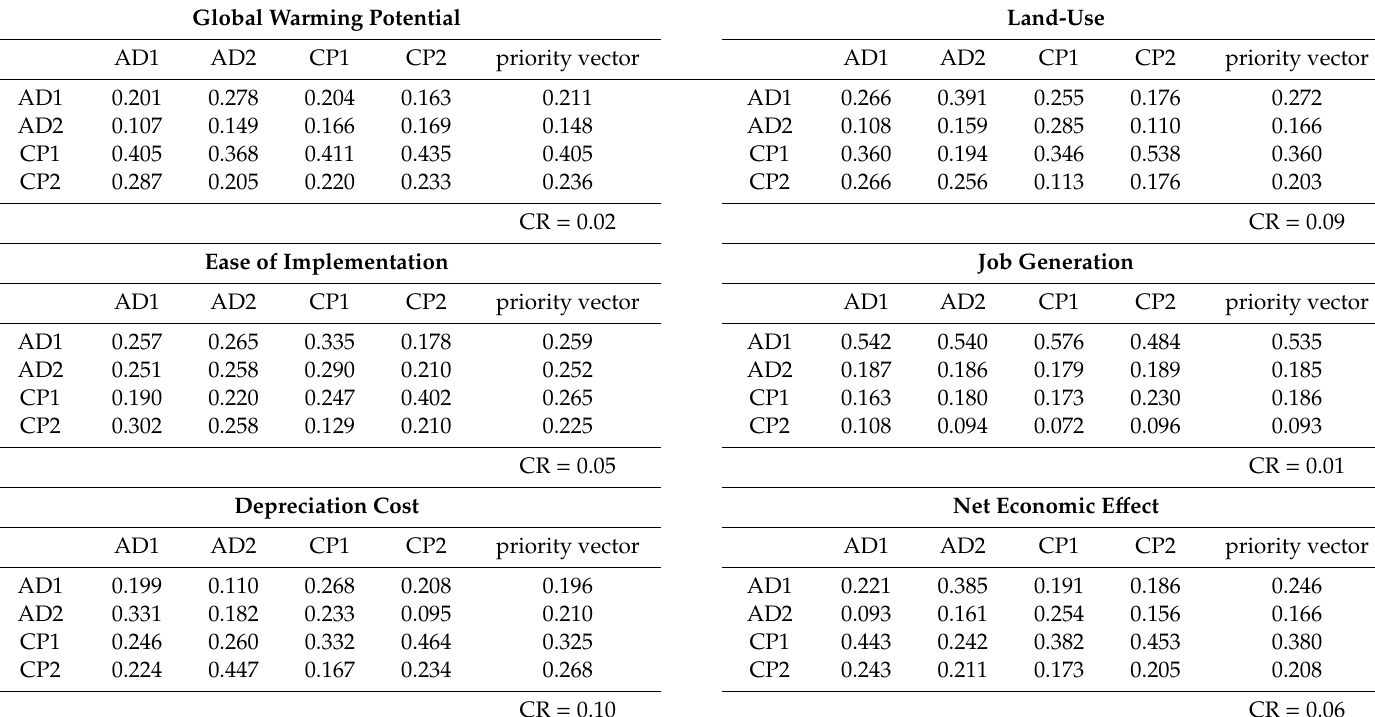
Table 8. FW-to-energy valorization alternatives comparison matrices for each evaluation